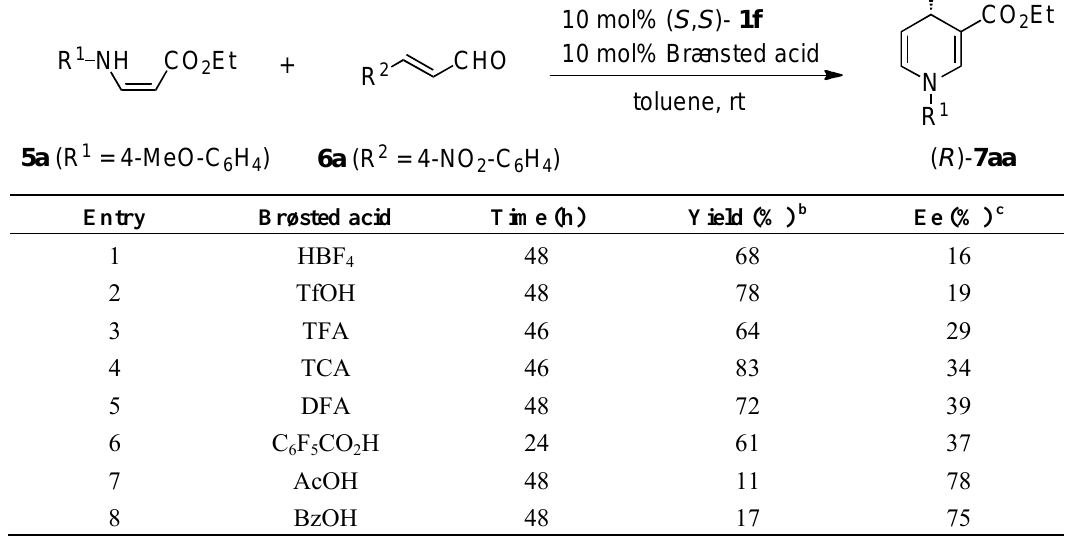
Table 2. Effect of Brønsted acids in the presence of 1f for the synthesis of 1,4-DHP 7aa . 10 mol% ( S , S )- 1f CHO+ R 1 NH 10 mol% Brænsted acid R 2 toluene, rt Brøsted acid Time (h) Yield (%) b